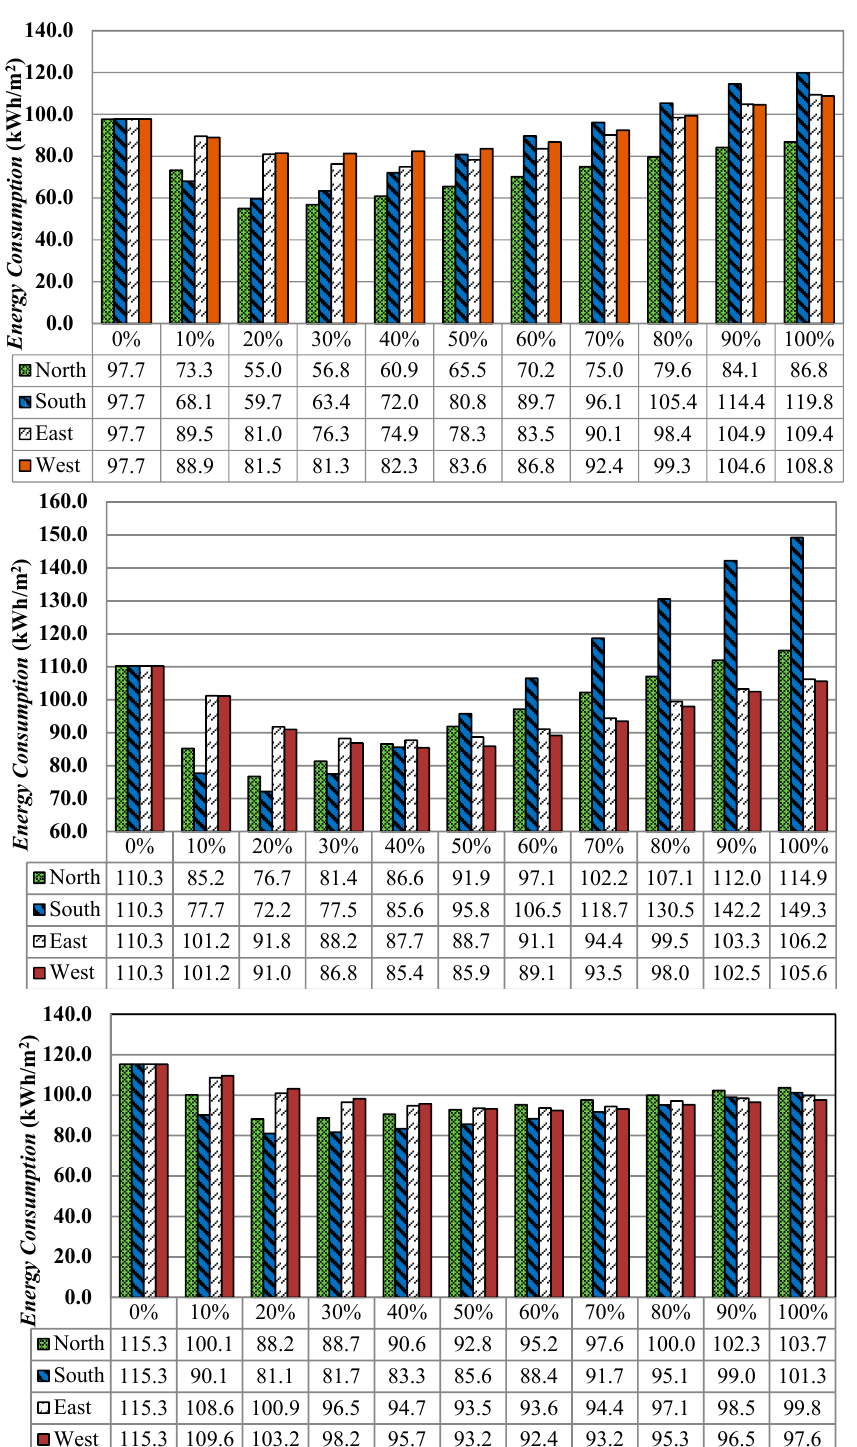
Figure 8. Annual total cooling, heating, and lighting loads of buildings with different percentages of windows at different facades in Bushehr (upper), Shiraz (middle), and Tabriz (below), Iran.